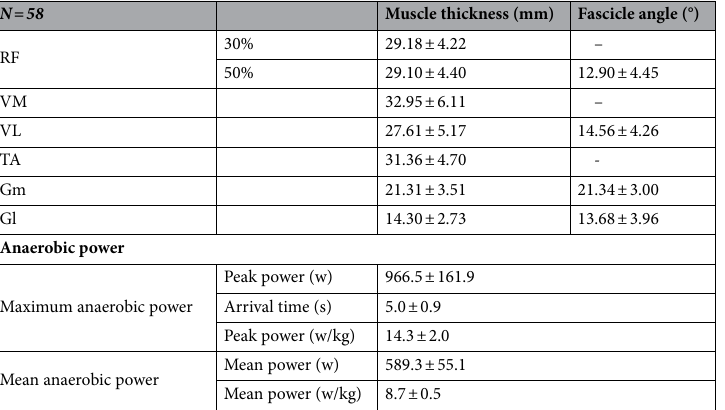
Table 1. Mean values of the muscle thickness, fascicle angle and anaerobic power measurements of athletes. Data are presented in mean ± SD values; Arrival time, arrival time to peak power.